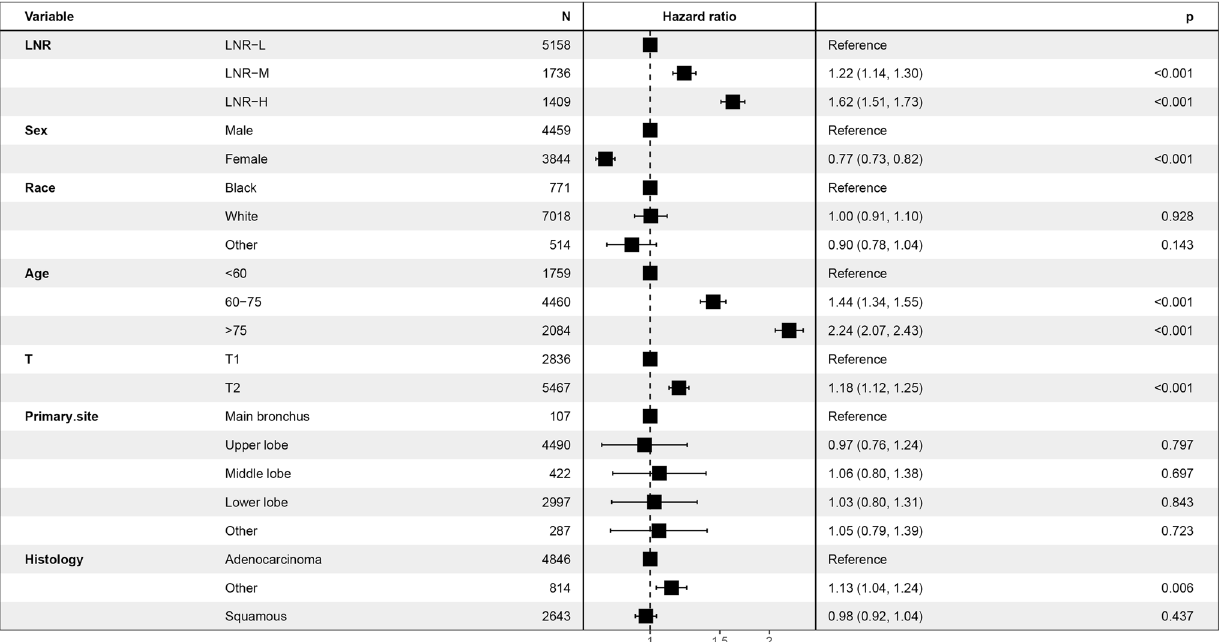
Fig. 6 Forest plot demonstrating the results of multivariate Cox regression analysis of OS predicted by LNR as a